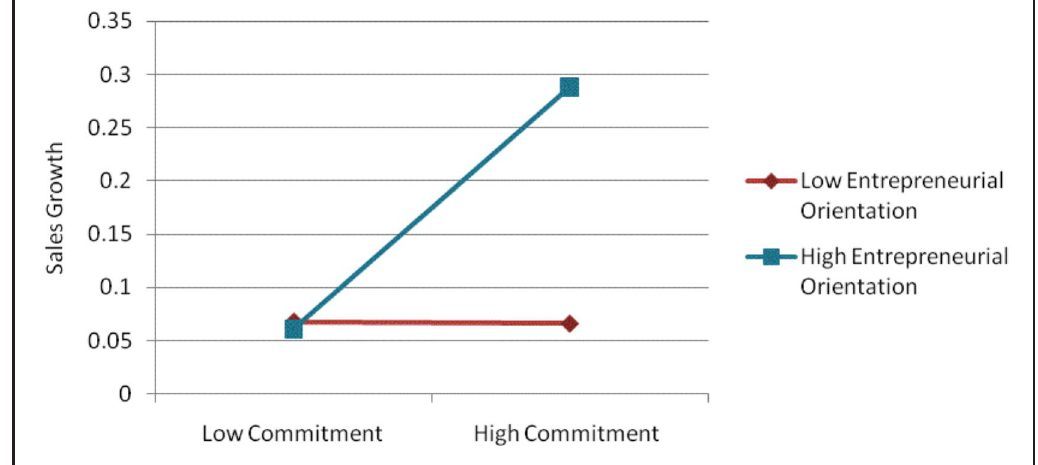
Figure 2. Interaction of Entrepreneurial Orientation and Commitment to Objectives